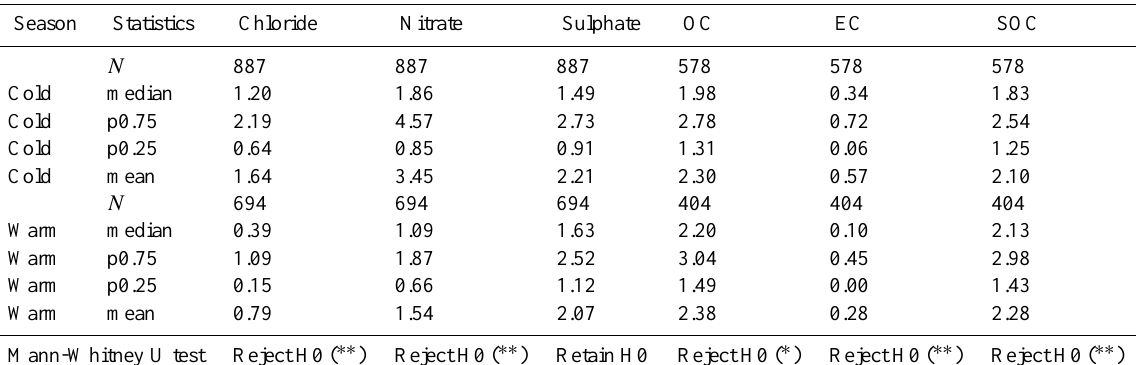
Table 2. Medians, 75th and 25th percentiles and arithmetic mean concentrations of chloride, nitrate, sulphate, organic carbon (OC), ele- mental carbon (EC) and secondary organic carbon (SOC) for the cold season (October to April) and warm season (May to September). Concentrations in µgm − 3 . The Mann Whitney U test tested the H0 hypothesis that the distributions are the same in both seasons. ∗∗ means that the significance level is 0.01 and ∗ means that the significance level is 0.05.